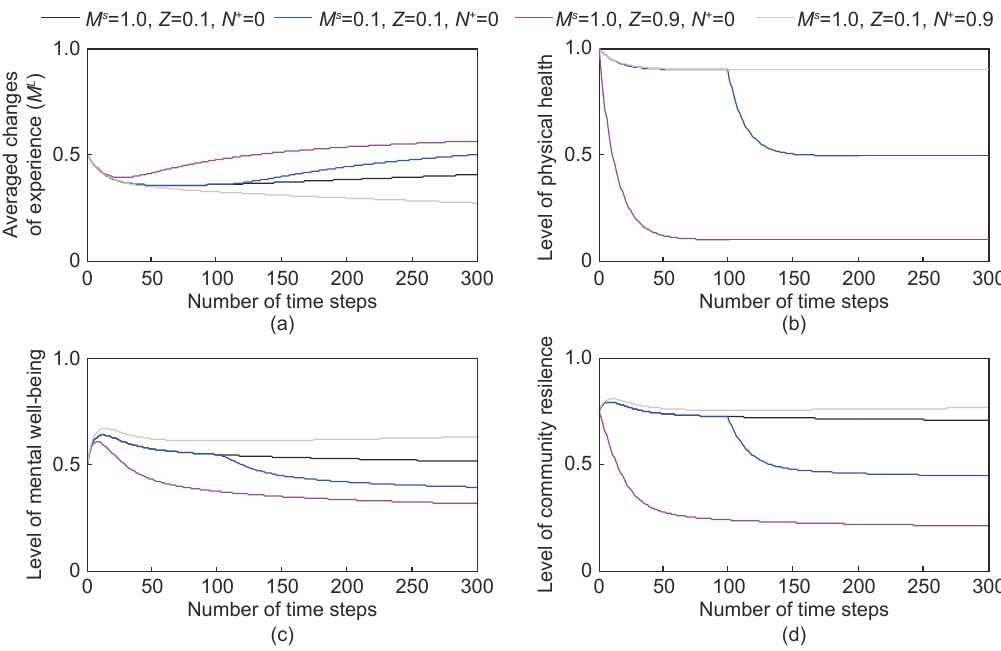
Fig. 8 Effects of the emergency services, the injury factor of disaster, and news polarity upon experience, physical and mental well-being, and community resilience. The grey lines represent the effects when all outside factors, i.e., the emergency services, the disaster, and the mass media, do not have a negative effect on the community. Understandably, there is more community resilience in this case compared to that of other scenarios for the time interval [0,